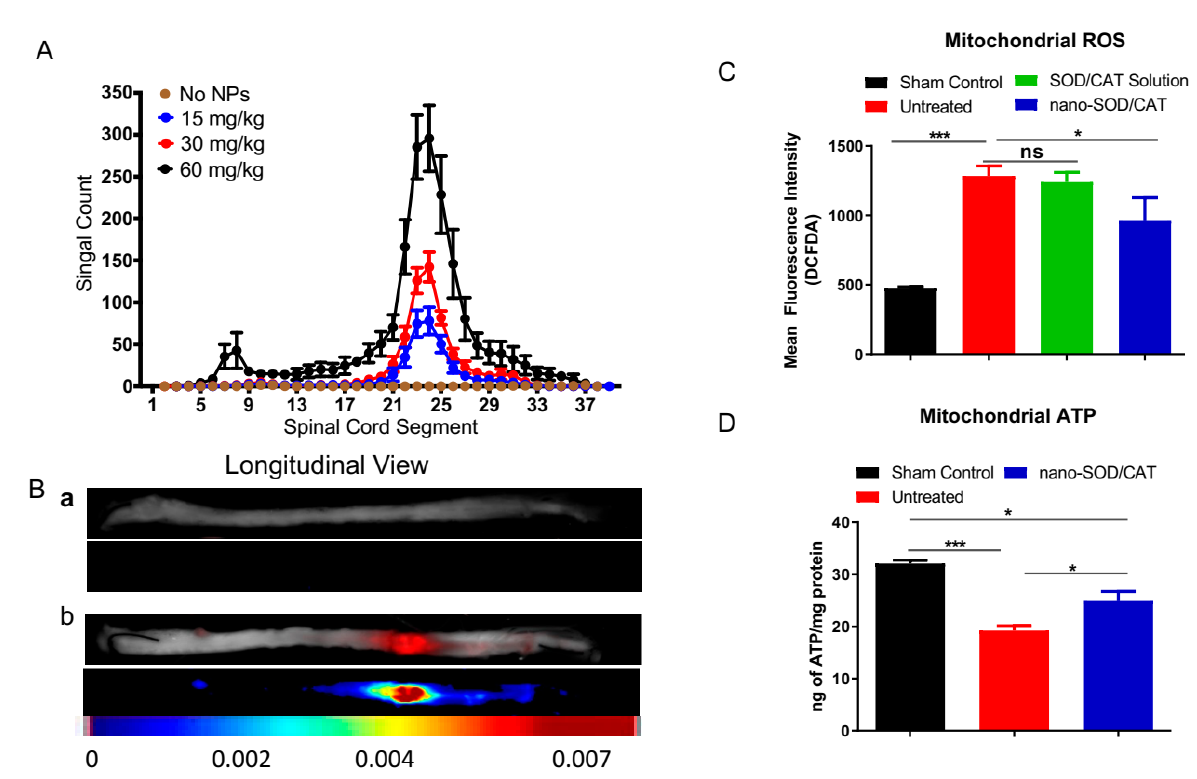
Figure 6. Antioxidant enzyme-based nanotherapy for spinal cord injury: Localization of nanoparticles at the lesion site following intravenous administration. Nanoparticles were injected 6 h post-injury, and spinal cords were analyzed for localization of the nanoparticles. Nanoparticles contained a near-infrared dye, and the spinal cords were analyzed 24 h after the injury using the Maestro Optical Imaging System site. Reproduced with permission from [350], copyright 2019 Elsevier. ( A ) Dose- dependent localization of nanoparticles at the lesion site. ( B ) Images of the spinal cord taken with Maestro Optical Imaging ( Ba ) Normal spinal cord without injury and nanoparticles. ( Bb ) Injured spinal cord from the animals that received dye-loaded nanoparticles intravenously. Efficacy of nano- SOD/CAT treatment ( C )-treated animals show reduced mitochondrial ROS levels. ( D ) Mitochondrial isolated from the spinal cord of the treated animals show more ATP production capacity than those isolated from the spinal cords of untreated animals. * p < 0.05; *** p < 0.001 Reproduced with permission from [350], copyright 2019